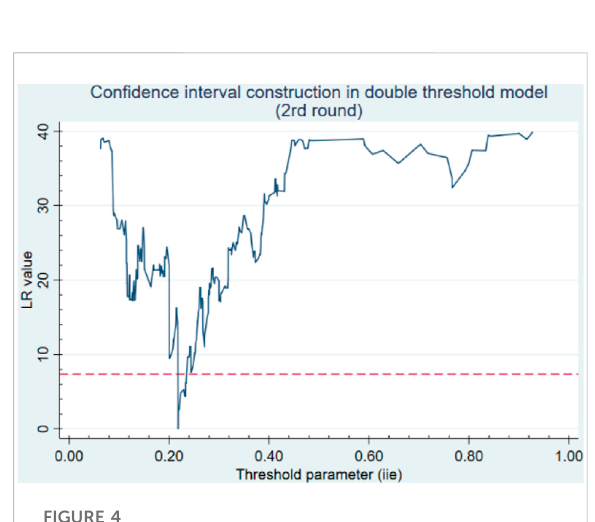
FIGURE 2 The LR map corresponding to the second threshold estimate of the threshold variable fi e .